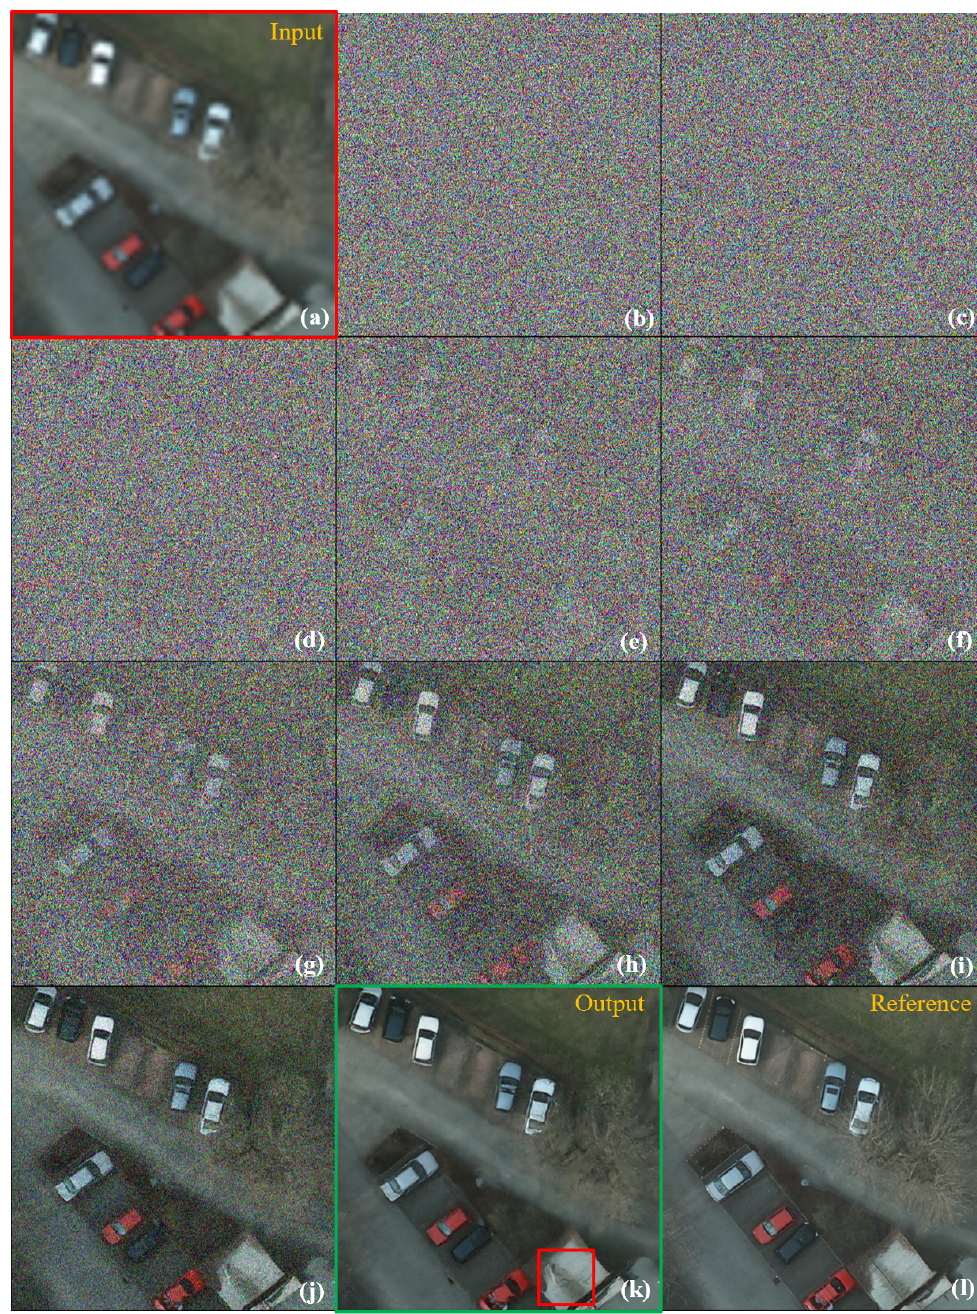
Figure 5. On ISPRS-Potsdam test dataset, 64 × 64 input resolution to visually compare the image reconstruction results. ( a : input) the input image. ( b – j ) the results of the image reconstruction process. ( k : output) image reconstruction results. ( l : reference) tag. Zoom-in for better